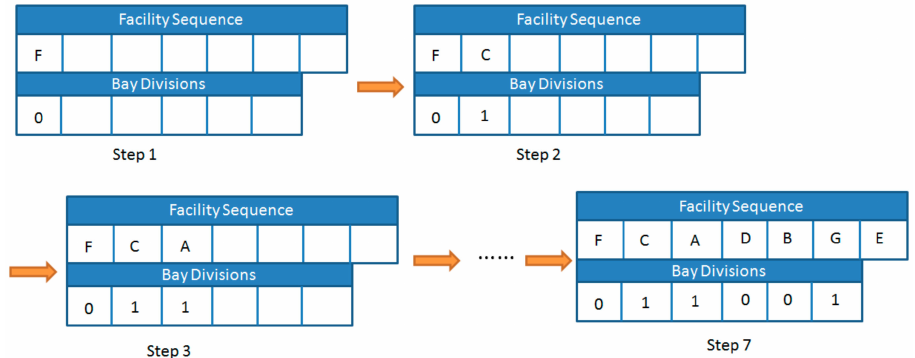
Figure 2. Steps of FBS encoding for the facility layout shown in Figure